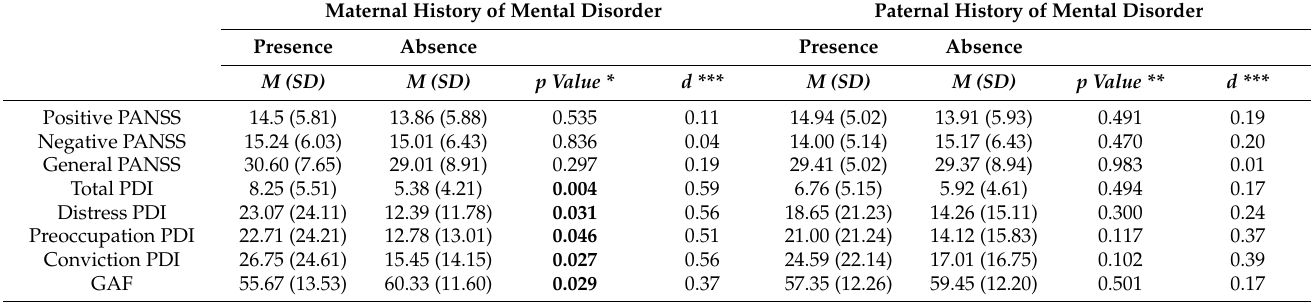
Table 2. Differences between maternal and paternal history of mental disorder and psychotic symp- toms and